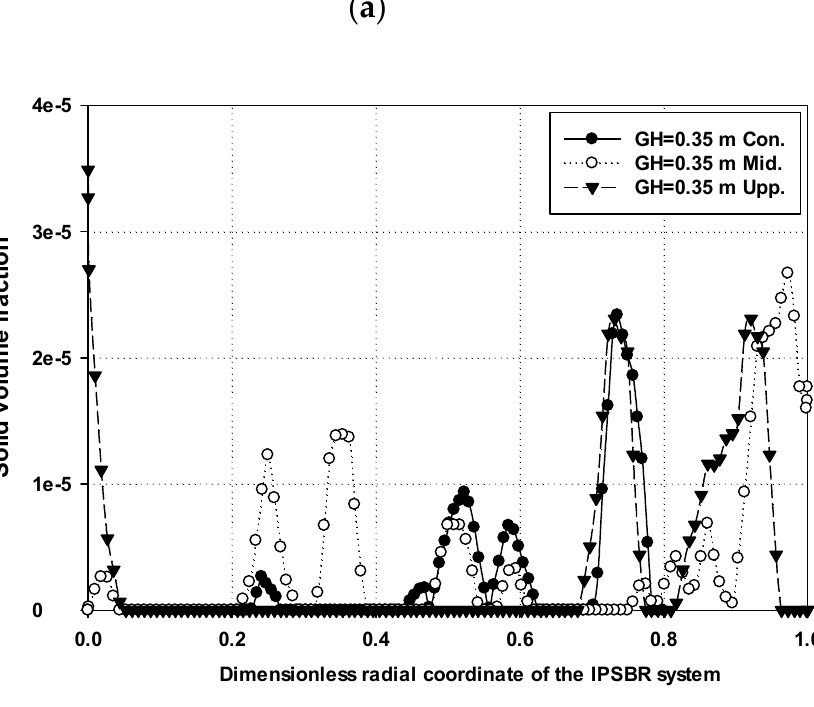
Figure 6. Effect of gas head (( a ) 0.15 m and ( b ) 0.35 m) on the average solid volume fraction at a constant feed gas velocity of 1 m/s, orifice diameter of 0.003 m, mixing particle diameter of 0.0135 m, and total mass of mixing particle of 0.06 kg/s in the conical, middle, and upper regions.